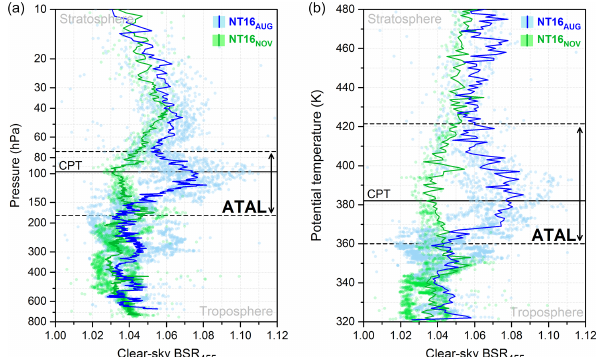
Figure 1. Backscatter measurements (BSR 455 ) in Nainital, India, in August 2016 versus pressure (a) and versus potential temper- ature (b) . Shown are BSR 455 values for aerosol (dots) and aver- aged aerosol profiles (solid lines), both without cirrus contributions for August (blue) and November (green). Black lines show the mean temperature lapse-rate minimum (lower dashed), cold point tropopause (CPT, solid) and top of confinement (upper dashed). The vertical black arrows indicate the ATAL region. ( a adapted from Fig. 11 of Brunamonti et al. (2018); b the ATAL boundaries and CPT are from Table 3 in Brunamonti et al.